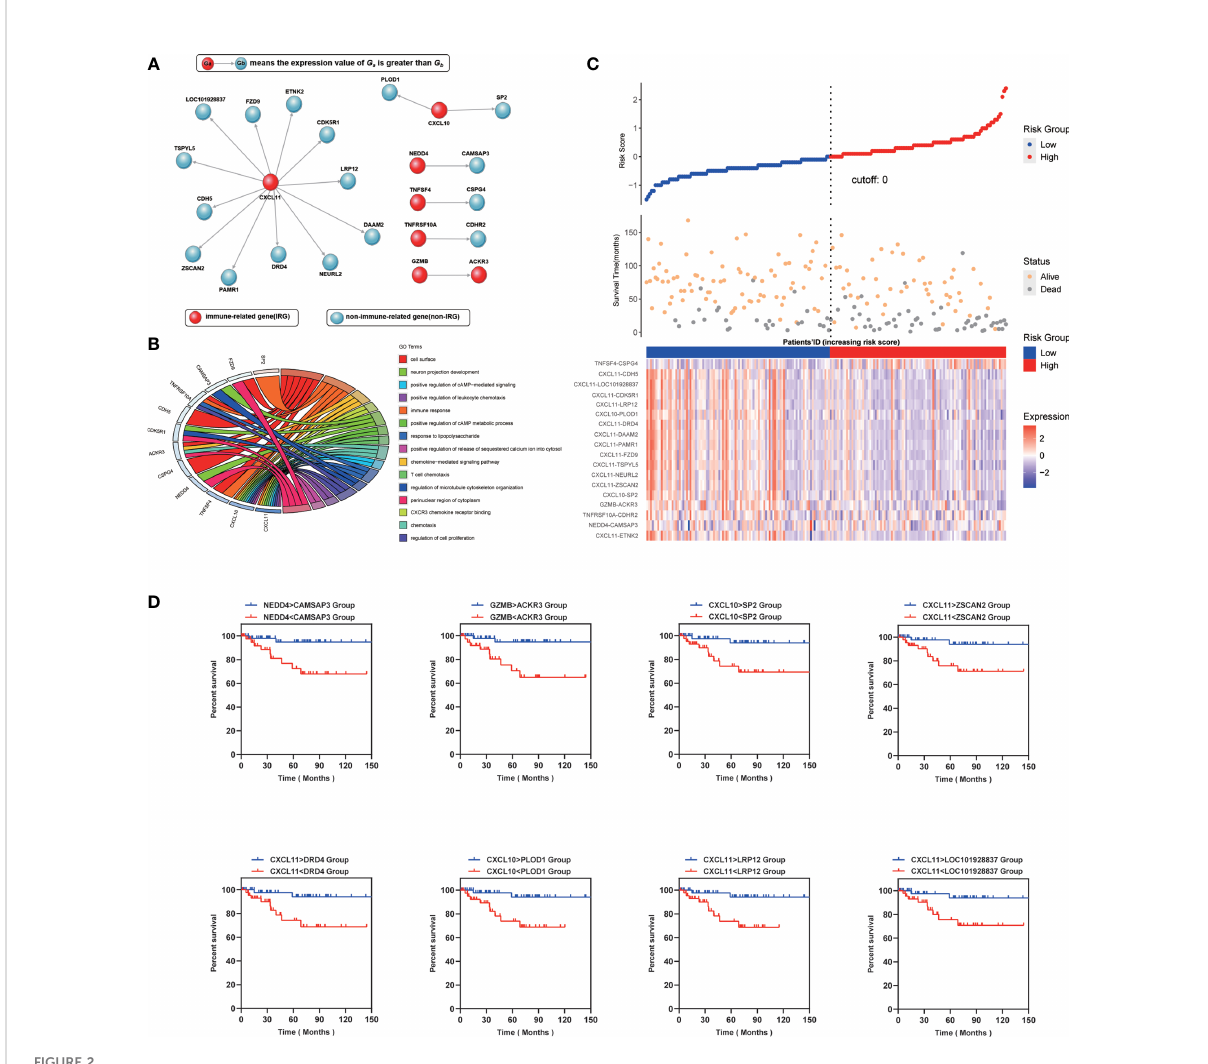
FIGURE 2 (A) Genetic makeup of IPS. (B) Enrichment distribution of differentially expressed genes in IPS. Different colors represent different access paths. (C) Up: The risk scores obtained by the COX regression of all patients are arranged in order of risk from low to high, and then a scatterplot is made. The X-axis is the serial number of the patient, and the Y-axis is the risk score. The blue dots are the low-risk group, and the red dots are the high-risk group. Middle: The X-axis is the patients ’ ID, the Y-axis is the survival time, the orange dots indicate the outcome is survival, and the gray dots indicate the outcome is death. Down: Heatmap of IPS pro fi les in the high- and low-risk groups. It is calculated as the expression value of the former gene minus the latter. (D) Kaplan – Meier curve analysis of eight representative immune-related gene pairs in validation cohort